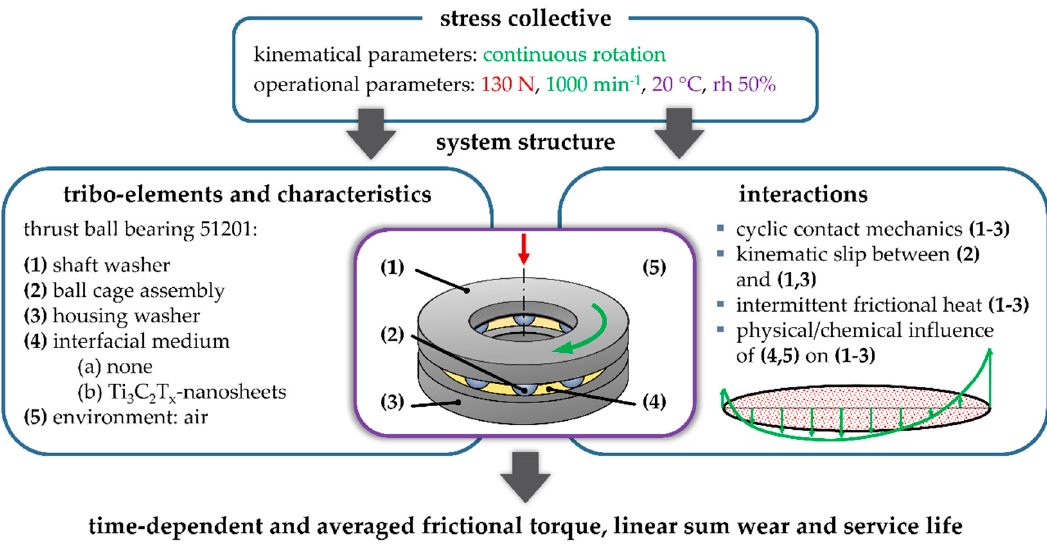
Figure 5. Example for tribological component testing as studied in [27].